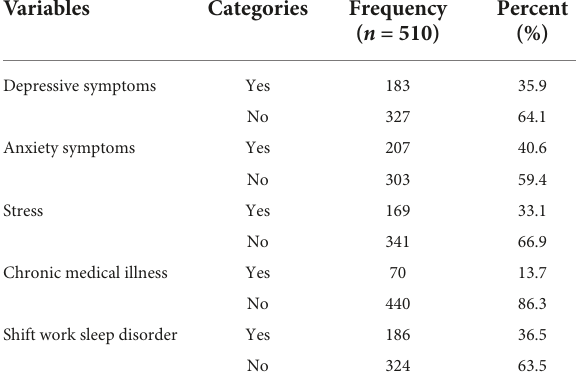
TABLE 2 Psychological, clinical, and shift work sleep disorder characteristics of nurses working at comprehensive specialized hospitals in Northwest Ethiopia, 2021 ( n = 510).